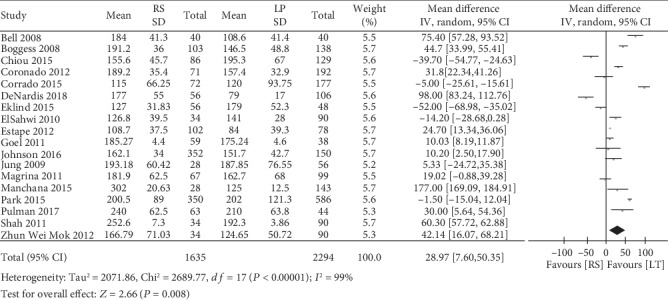
Forest plot of the OT between the RS and LT groups.